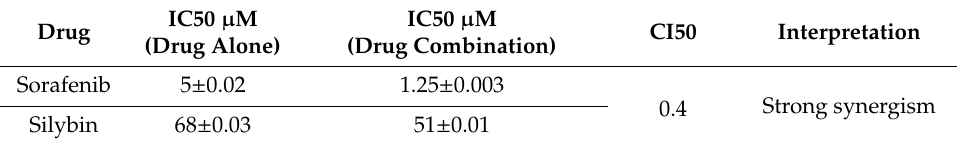
Table 2. Synergism between silybin and sorafenib.